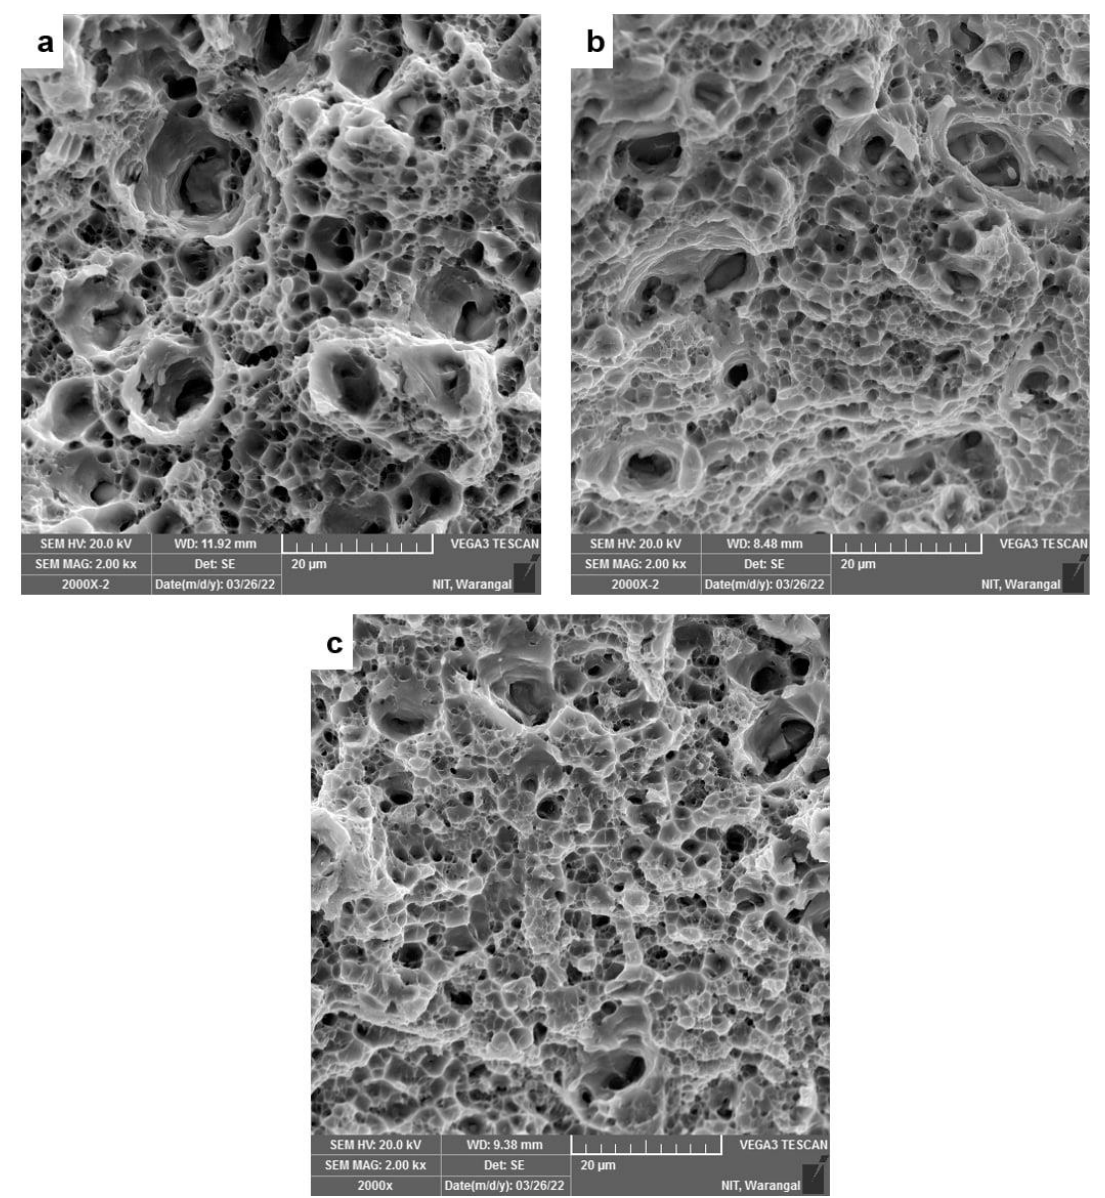
Figure 15. Fractographs of rotary friction welded samples ( a ) AA5083/AA7075-STA, ( b ) Fractographs of rotary friction welded samples ( a ) AA5083/AA7075-STA, AA5083/AA7075-ST, and ( c ) AA5083/AA7075-PWHT. ( b ) AA5083/AA7075-ST, and ( c )